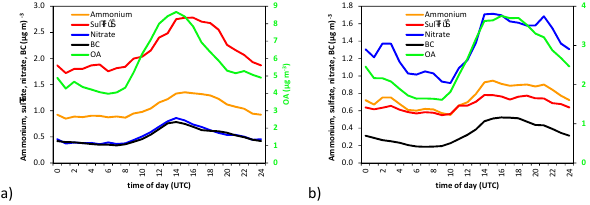
Figure 5. Average daily pattern for (a) the warmer and (b) the colder periods. Note that OA is plotted on the right axis.